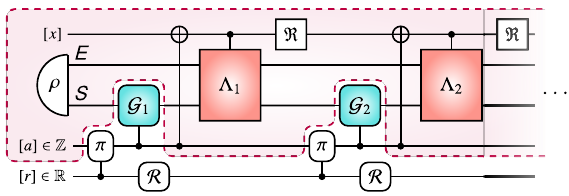
FIG. 8. A circuit describing both gate-dependence and non-Markovianity. The full system consists of a SE system in state ρ and classical registers [ x ], [ a ] and [ r ]. The π oper- ations are permutations, R are randomizing operations and R are reset operations. Vertical lines joining with • denote control with the corresponding classical register: essentially the CNOT gates (control with ⊕ in the [ x ] extreme) will carry the depen- dence from the applied gates at every step. Finally in RB the inverse operation (with an associated error) would be applied